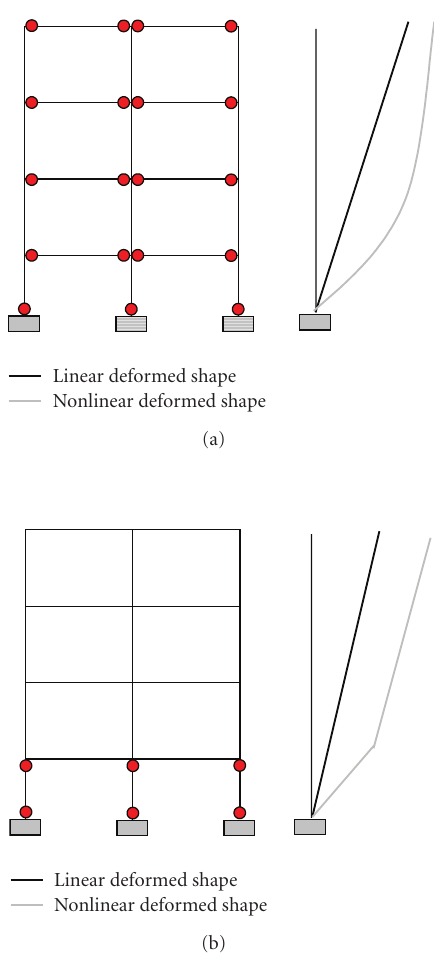
Figure 2: Response mechanisms for a frame and the associated deformed shapes (a) beam-sway mechanism, (b) column-sway